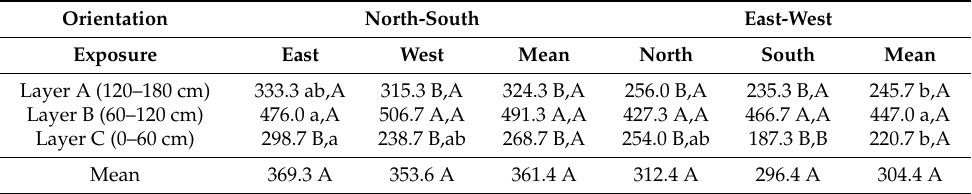
Table 9. Mean hulled fruit yield (FY, g). The first letters denote significant differences between layers for a given exposure; the second letters denote significant differences between exposures for a given layer (SNK test). Lower case letters denote statistical differences with p = 0.05. Capital letters denote statistical differences with p = 0.01.